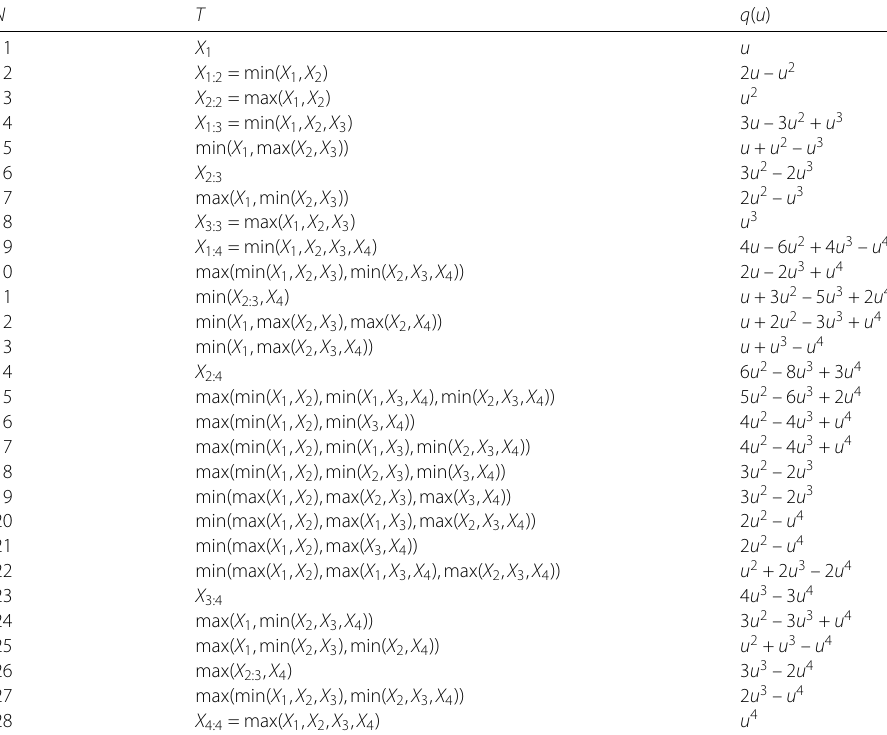
Table 1 Distortion function q for a coherent system with 1–4 i.i.d.